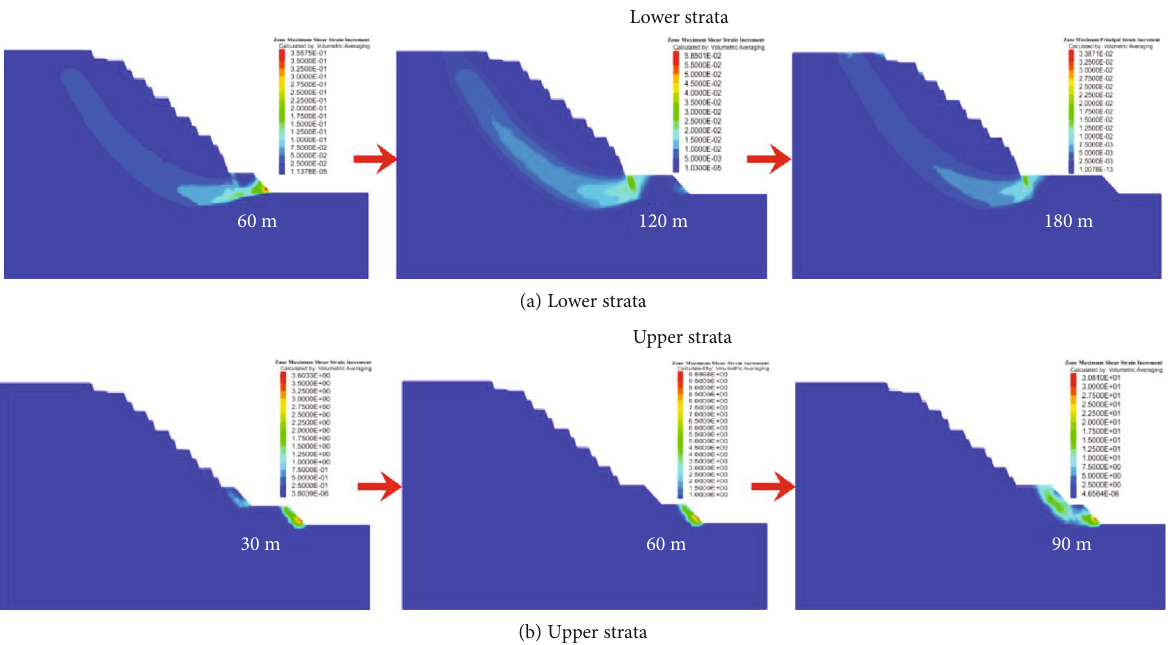
Figure 11: Variation law of slope shear strain increment under di ff erent inner row